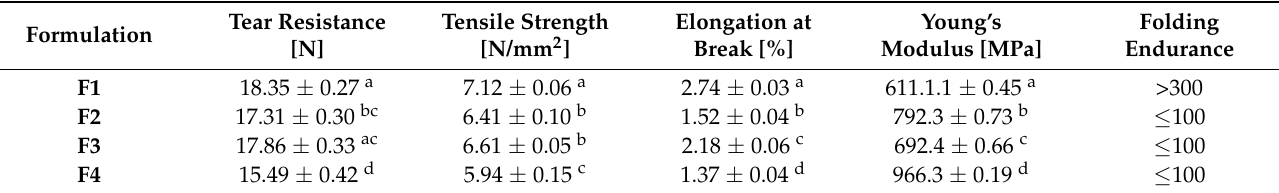
Table 4. Physicomechanical properties of films ( n =